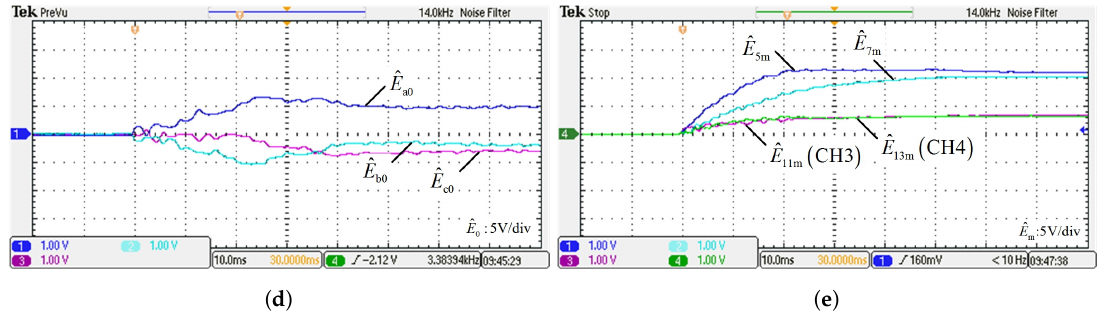
Figure 12. Experimental results when three-phase unbalanced voltages are suddenly injected with DC offsets and higher harmonics. The waveforms of ( a ) e abc ; ( b ) ˆ f , ˆ ϕ ba , and ˆ ϕ ca ; ( c ) ˆ e abc and ˆ θ a ; ( d ) ˆ E abc0 ; ( e ) ˆ E 5m , ˆ E 7m , ˆ E 11m , and ˆ E 13m .